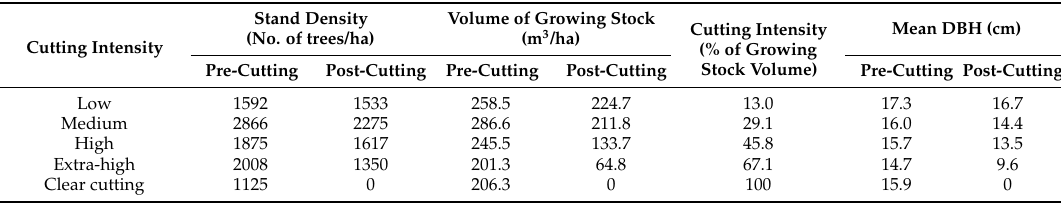
Table 1. Stand characteristics of treatment